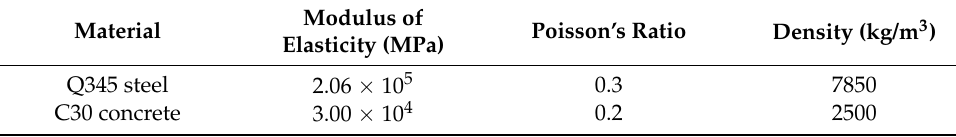
Table 3. Material physical parameters.